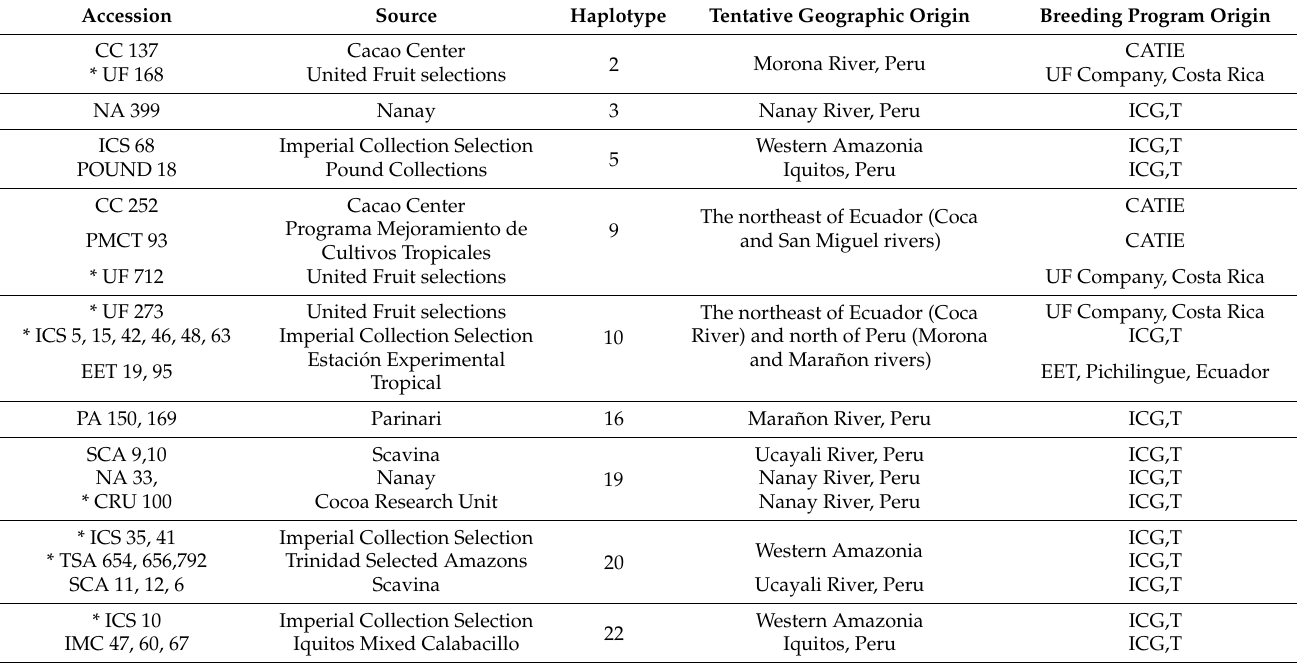
Table 4. Chloroplast haplotypes observed in cacao ( Theobroma cacao L.) breeding populations, tentative geographic origin of haplotypes, source, and breeding